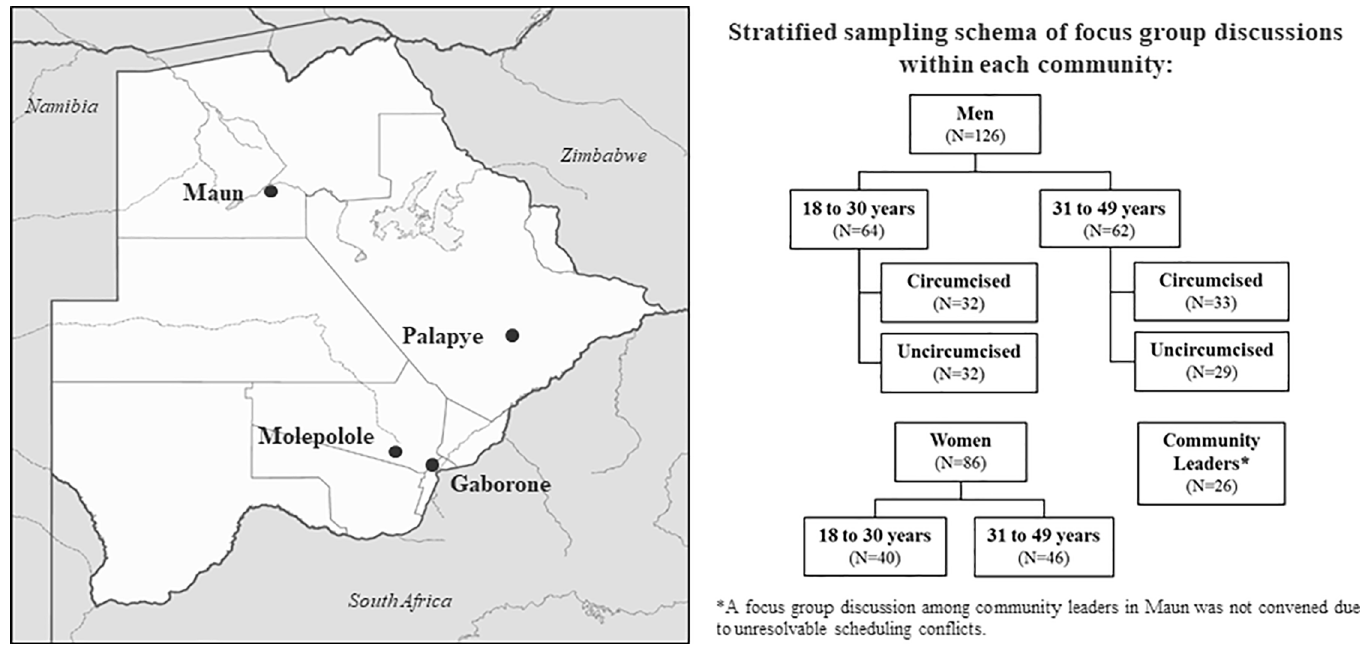
Fig 1. Map of selected communities and stratified sampling schema of focus discussion groups among men, women and community leaders according to age and circumcision status, Botswana, July to November 2013.